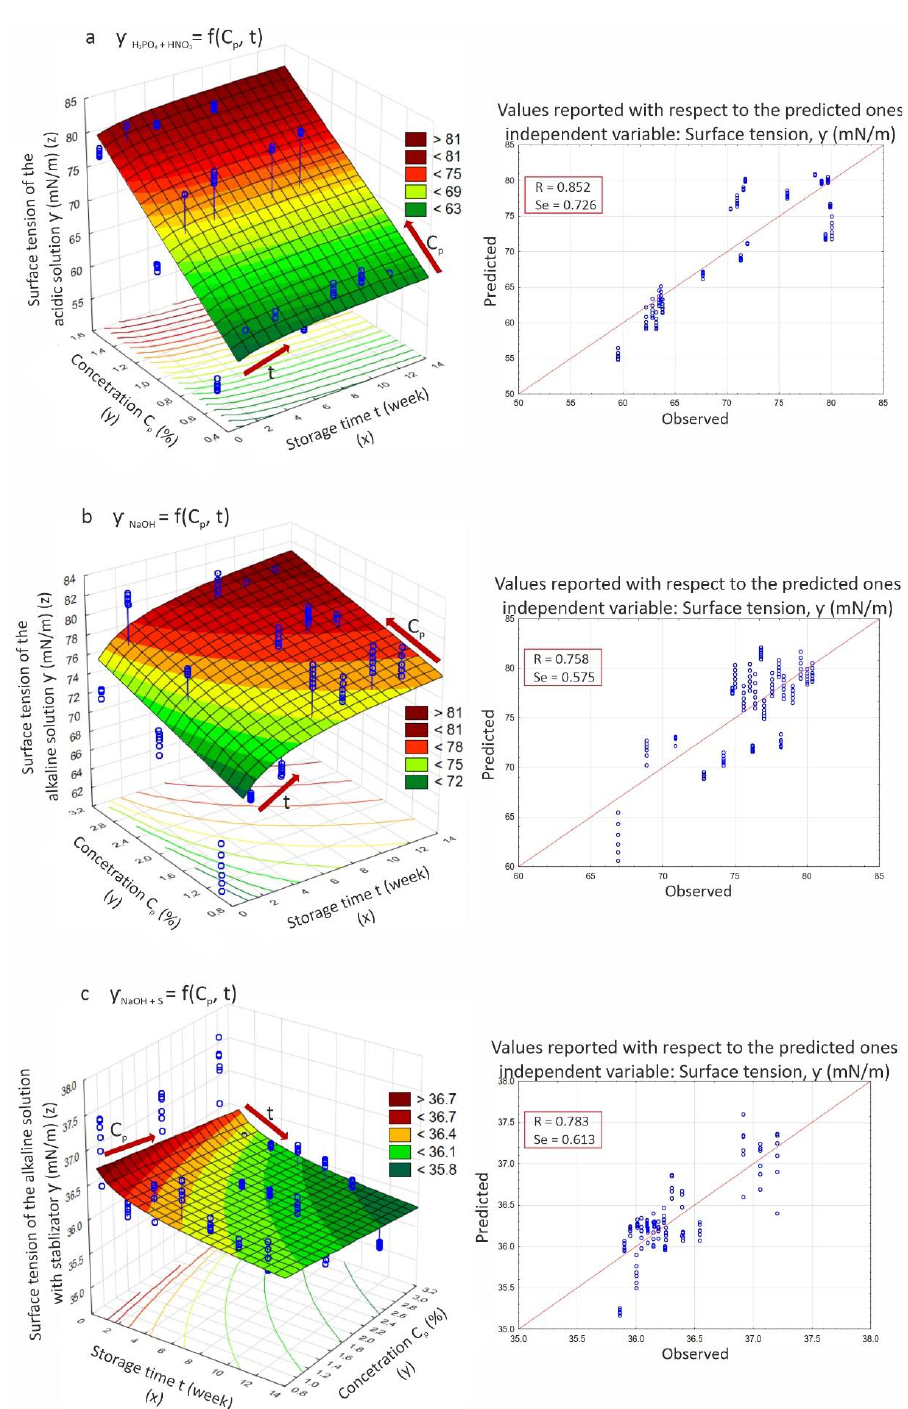
Figure 4. Relationship between equilibrium surface tension and storage time of solutions of different concentrations: ( a ) acidic, based on a 1:1 mixture of H 3 PO 4 + HNO 3 ; ( b ) alkaline, based on NaOH; ( c ) alkaline, based on NaOH with stabilizer.